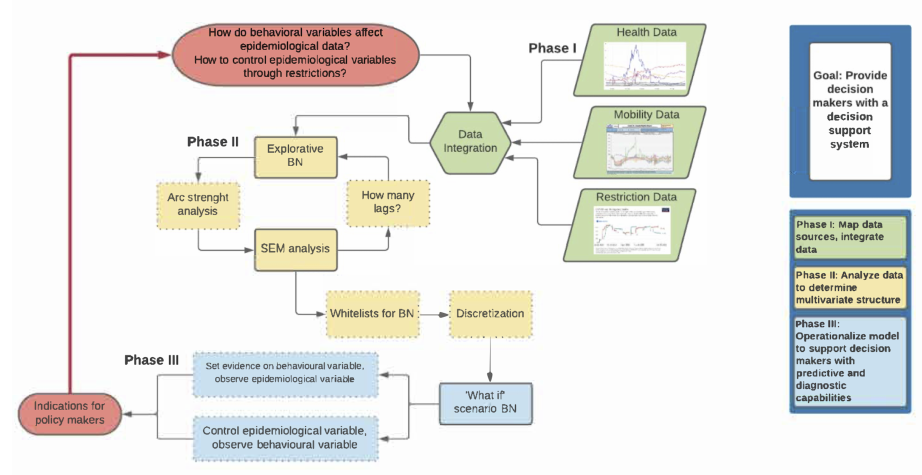
Figure 1. Flow chart describing the ensemble